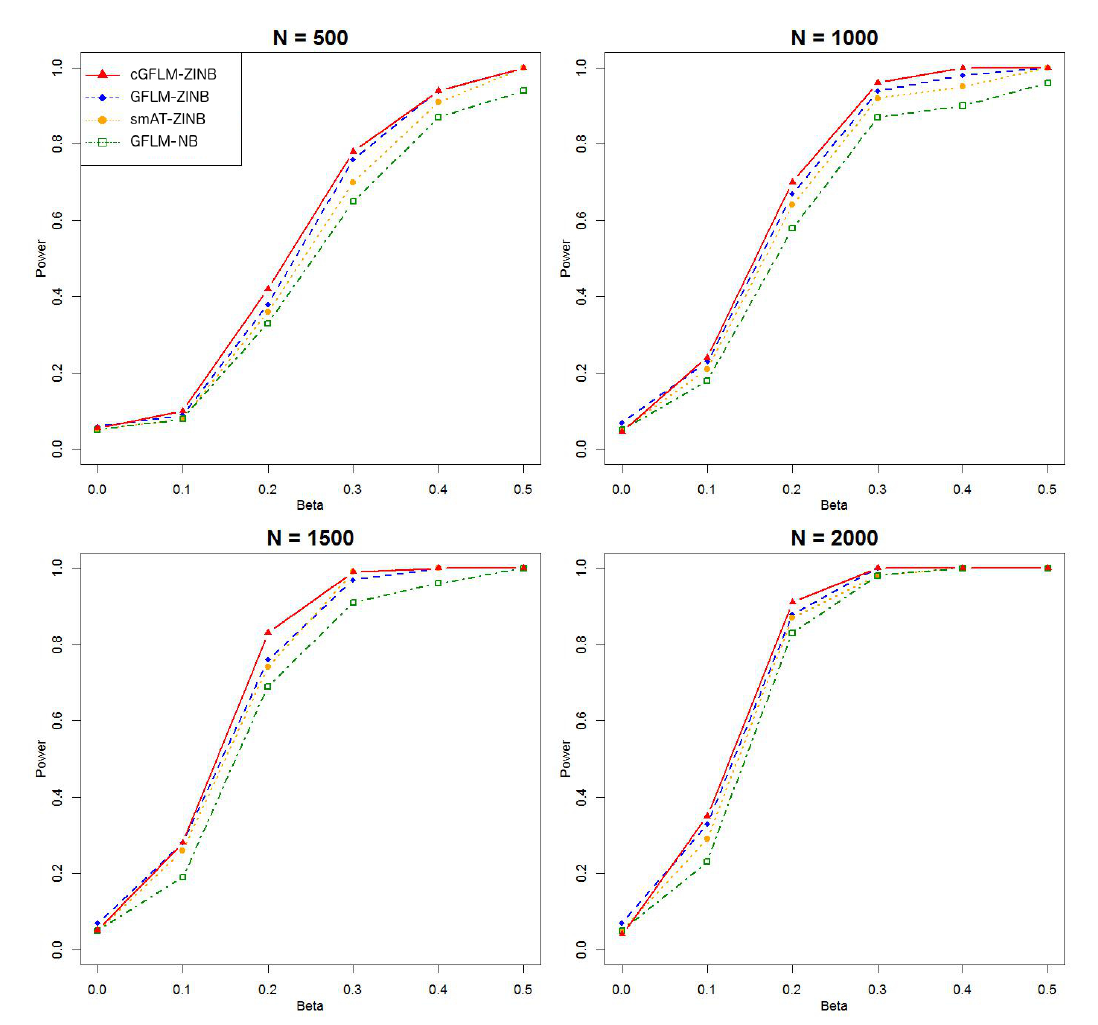
Figure 7. Power simulation for ZINB outcomes based on random LD blocks, two causal loci, effect in NB